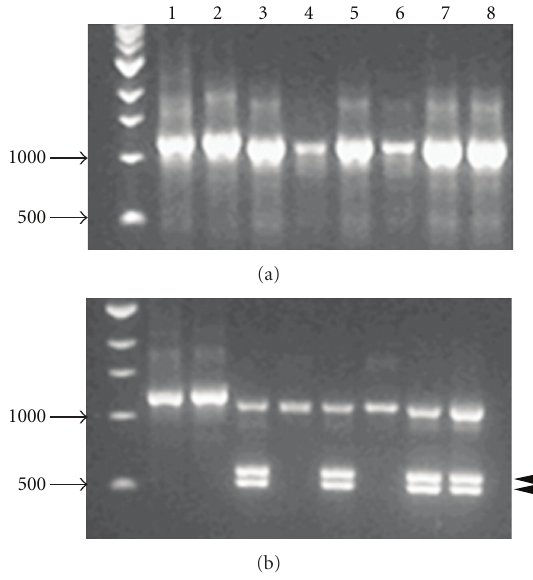
Figure 1: (a) Amplification of a segment of the PPX2 gene with the primers ARMS7-F and PPX2 ex10-R. (b) Digested PCR products with the enzyme EciI. Separation of fragments on a 1% w/v agarose gel with a 1-kb DNA ladder (NEB). Lanes 1–8 represent the following accessions: (1) A. tuberculatus PT43, (2) A. tuberculatus MH320, (3) A . retroflexus PT25, (4) A. palmeri MH253, (5) A. hybridus MH154, (6) A. palmeri MH247, (7) A. powellii MH242, and (8) A. powellii